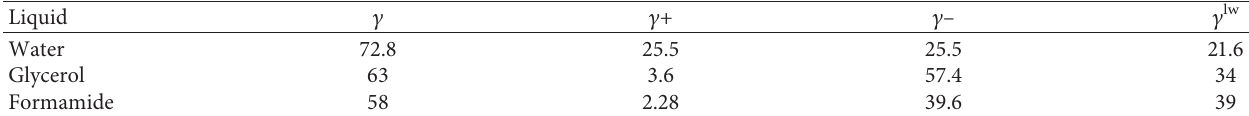
Table 7: SFE components of the probe